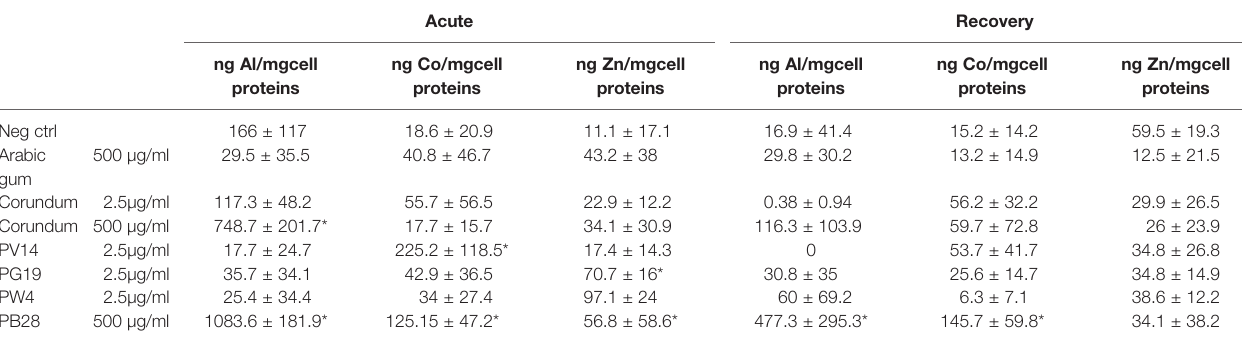
TABLE 2 | Intracellular ion content after exposure to pigments.